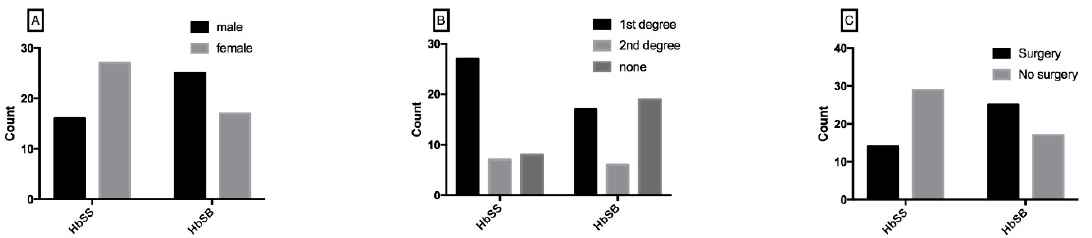
Figure 1. Association between SCD type and patient demographic and clinical characteristics. ( A ) Association between patients’ gender, ( B ) consanguity, and ( C ) surgical history with SCD type.